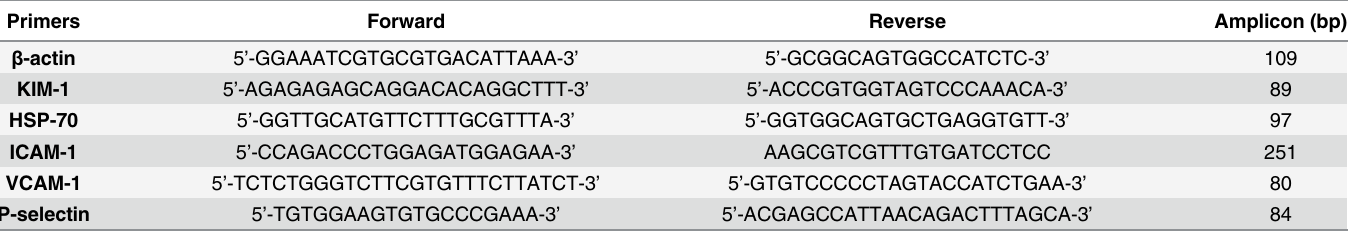
Table 2. qRT PCR primers of the housekeeping gene ( β -actin), KIM-1, HSP-70, ICAM-1, VCAM-1 and P-selectin primers and their sequences.